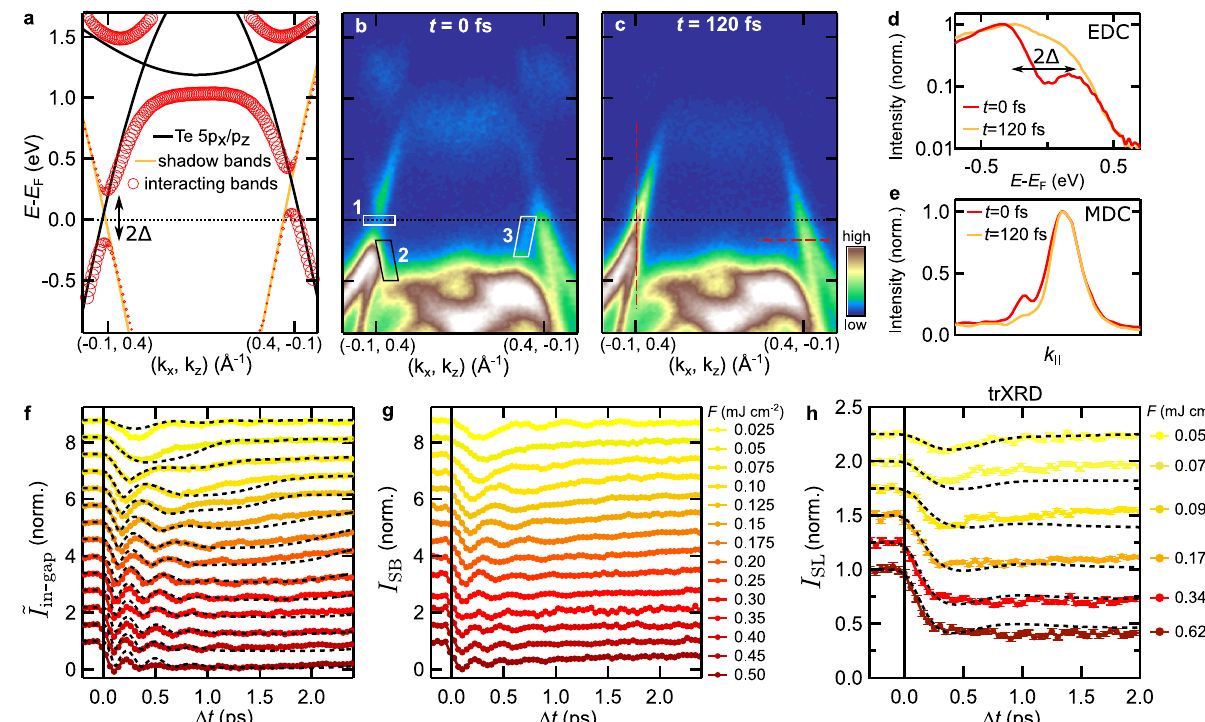
Fig. 2 CDW band structure dynamics. a Tight-binding bands along the momentum-direction indicated by the dashed gray line in Fig. 1b. The black and orange curves correspond to the non-interacting Te main and shadow bands, respectively. The red circles mark the hybridized bands with interaction potential Δ . The circle size illustrates the spectral weight. b , c trARPES measurements ( F = 0.45 mJ cm − 2 ) along the momentum direction shown in a . At t = 0 fs, the energy gap at E F (box 1) and shadow bands (boxes 2, 3) indicate the CDW order. After 120 fs, the CDW vanishes, and the energy gap and shadow band intensity are strongly suppressed. d – e Energy and momentum distribution curves along the dashed vertical and horizontal lines in c , respectively. f Inverted in-gap intensity ~ I in (cid:1) gap ¼ 1 (cid:1) I in (cid:1) gap with in-gap intensity I in − gap (box 1 in b , normalized by the respective pre-excitation values) as function of pump-probe delay for various fl uences (displaced vertically). Normalized time-dependent Ginzburg – Landau simulations are shown in black. For details of the model, see main text and Supplementary Note 1. g Normalized shadow band intensity extracted from box 2. The shadow band intensity obtained from box 3 is shown in Supplementary Fig. 1. h Time evolution of the (2 10 1 + q CDW ) SL peak intensity for various fl uences (displaced vertically) with layered Ginzburg – Landau simulations, see Supplementary Note 3. The curves are normalized by their respective pre-excitation values. The error bars correspond to one standard deviation from photon counting